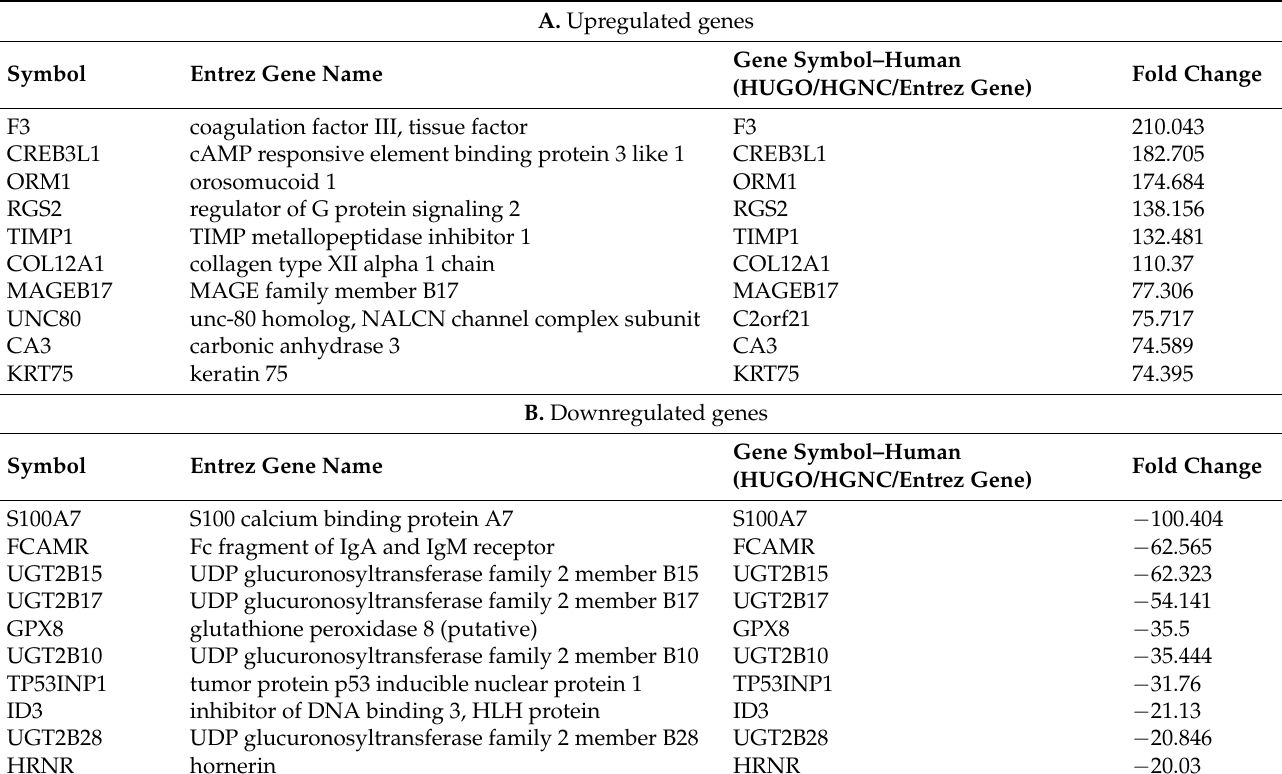
Table 1. Upregulated and downregulated genes. A. Upregulated